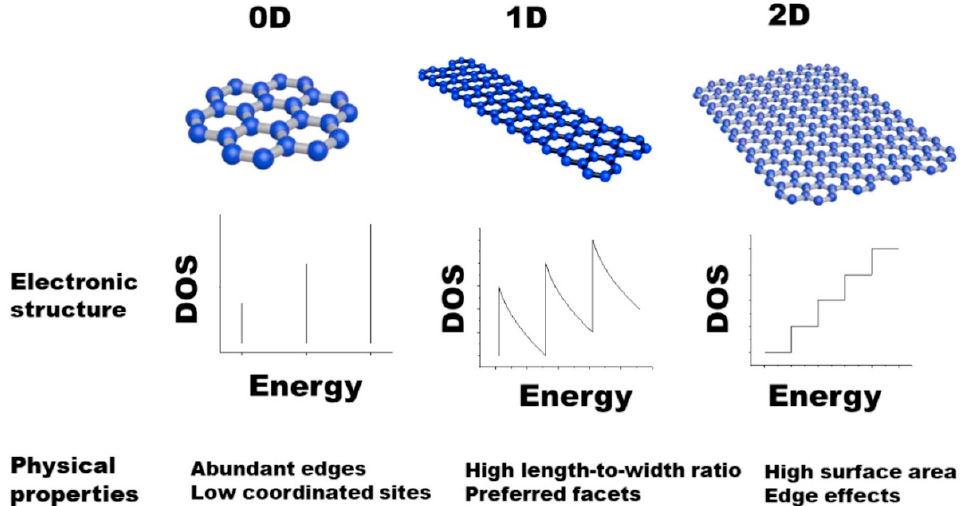
Figure 2. Density of states (DOS) of 0D, 1D, and 2D materials plotted vs. energy and correlated with physical properties of corresponding structures. Reprinted (adapted) from reference [18], copyright (2020) Elsevier.